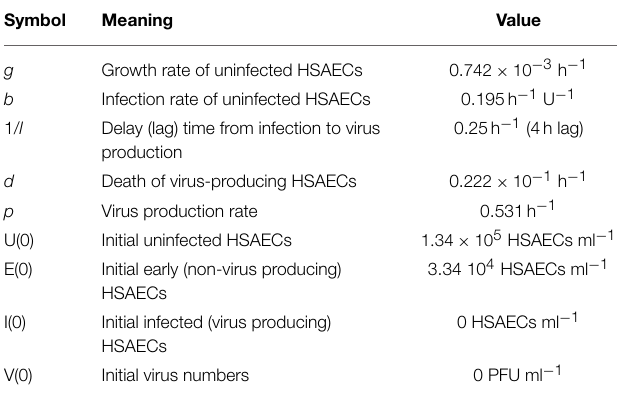
TABLE 1 | Model parameters and initial conditions estimated from